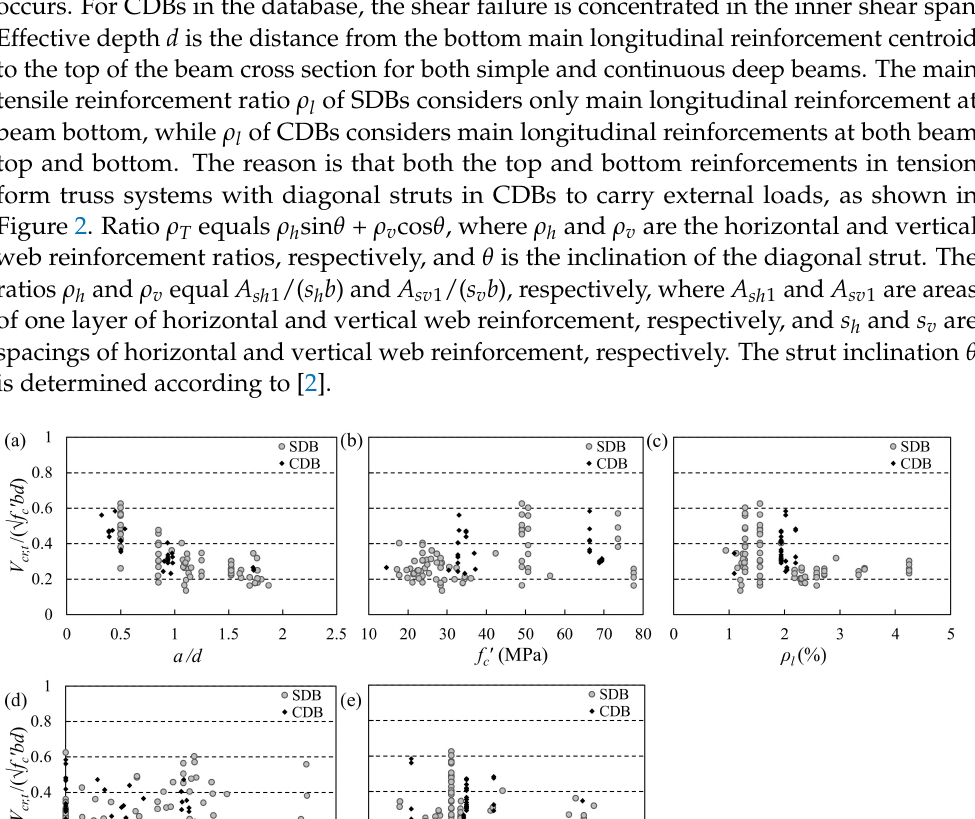
Figure 1. Relationship between dimensionless diagonal tension cracking strength V cr,t/ ( design parameters. ( a ) Shear span-to-effective depth ratio a / d ; ( b ) concrete compressive strength f c (cid:48) ; ( c ) main tensile reinforcement ratio ρ l ; ( d ) distributed reinforcement ratio ρ T ; ( e ) effective depth d